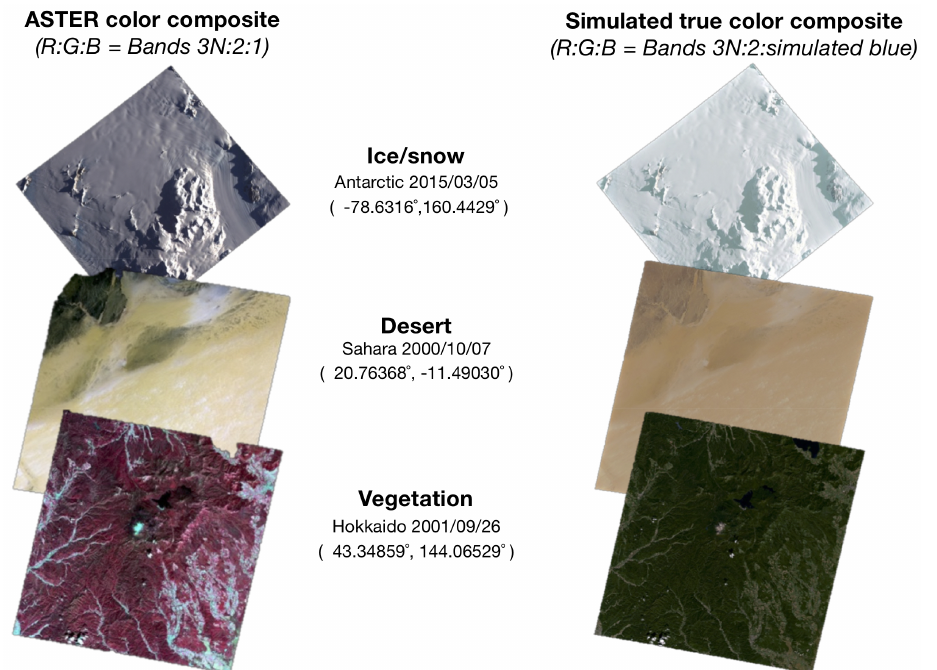
Figure 2. Examples of ASTER granules over different areas (ice/snow, desert, vegetation) rendered either with the false color composite (R:G:B = Bands 3N:2:1) on the left hand side, or with the simulated true color composite (R:G:B = Bands 3N:2:simulated blue) on the right hand